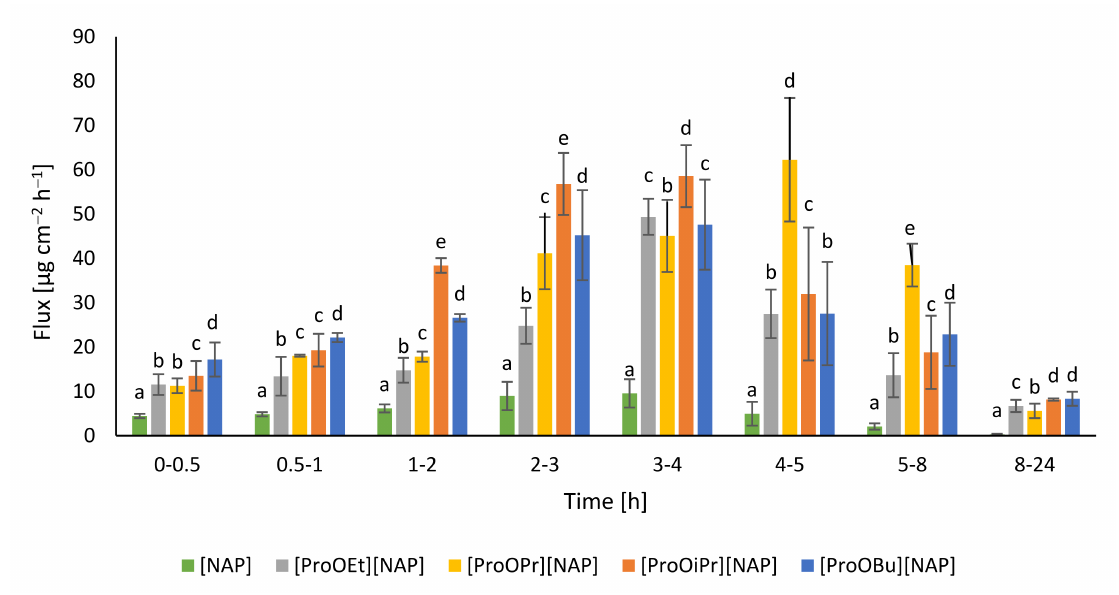
Figure 12. The permeation rate of naproxen and its derivatives during the 24 h permeation; different letters indicate significant differences between the tested compounds; (the letter ‘a’ stands for the compounds with the lowest permeation in a given time point, while the letter ‘e’—the compounds with the highest permeation at a given time point); α = 0.05 (Mean ± SD, n = 3). Statistically significant difference was estimated using the ANOVA